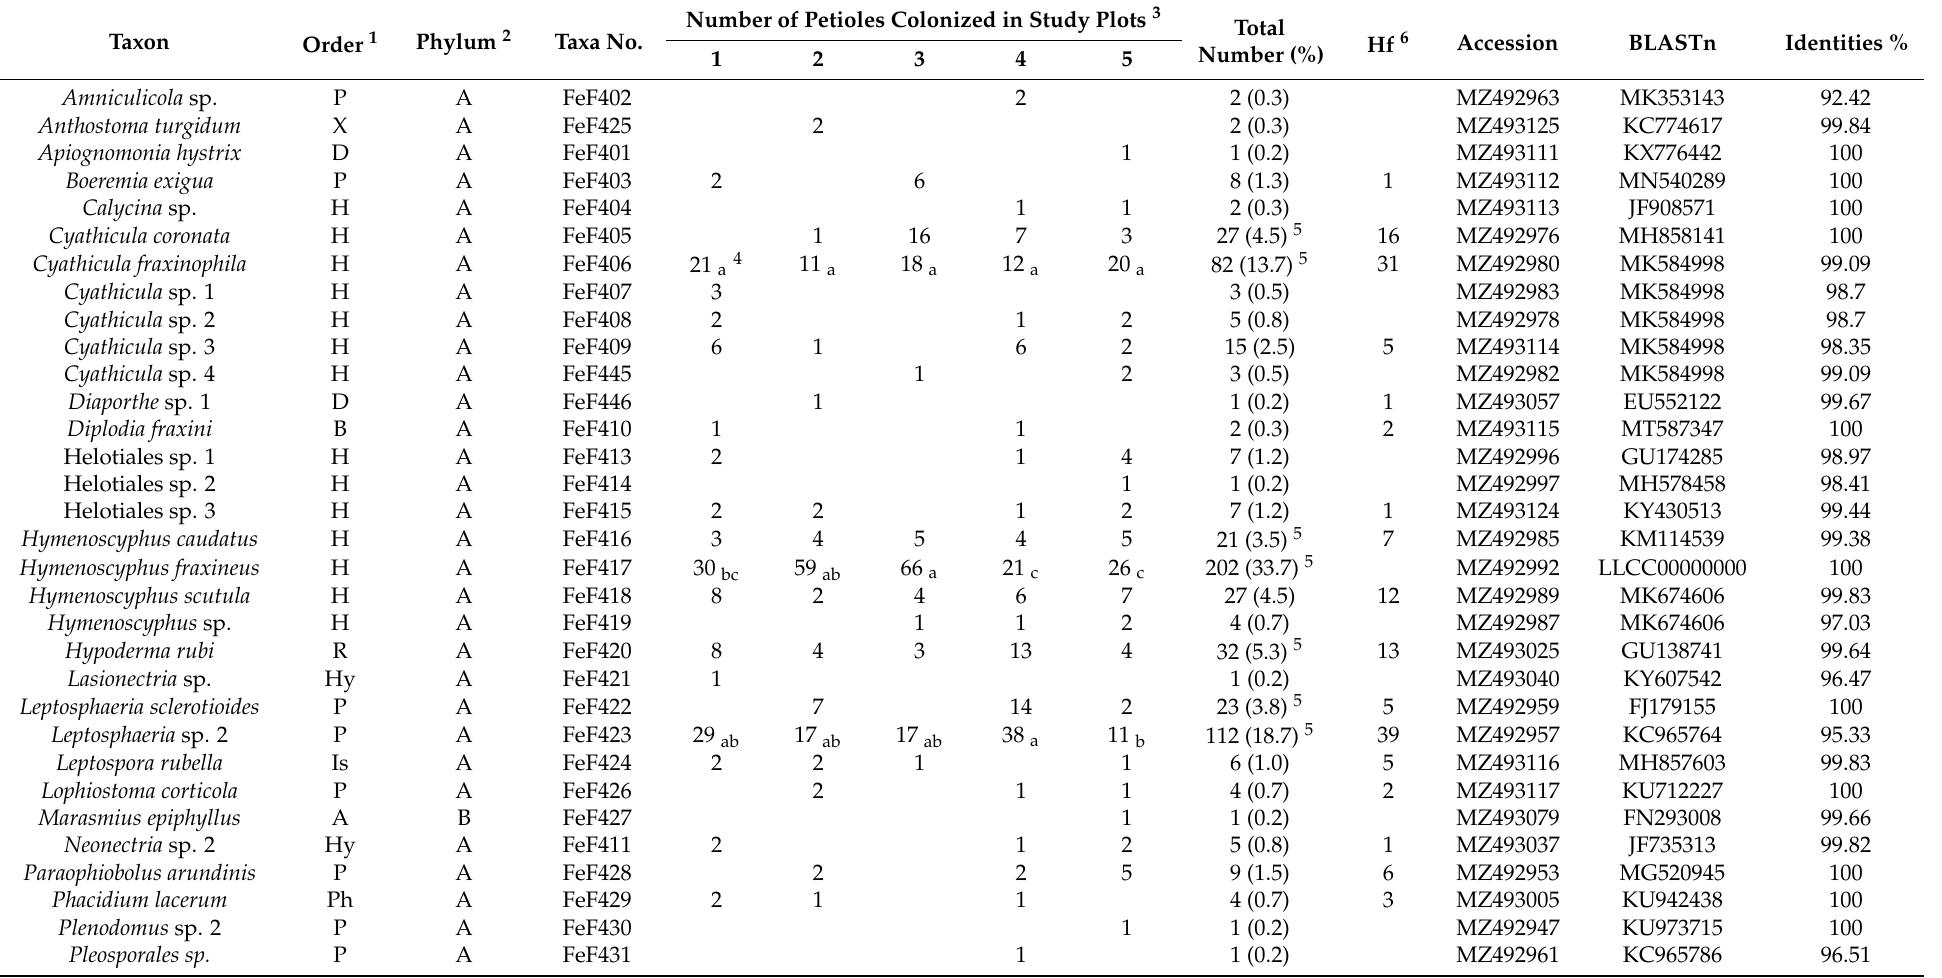
Table 3. Fungi detected in situ by inventory of fruit bodies on the previous year’s leaf petioles of F. excelsior in five forest stands, in southern Poland in